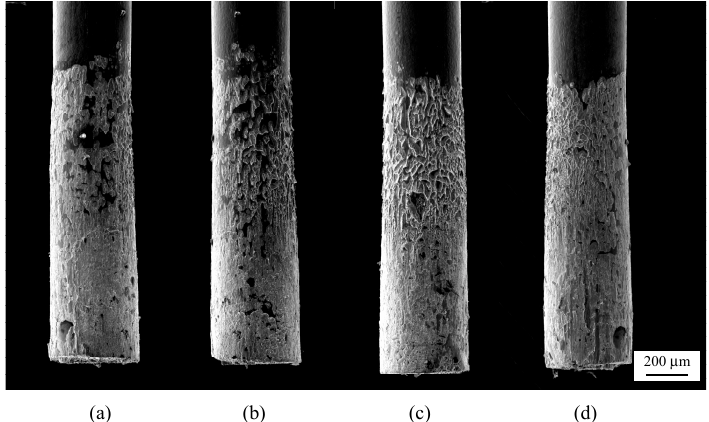
Figure 6. Surface of copper wire (SC-2-1) after pullout test taken in four orthogonal directions: